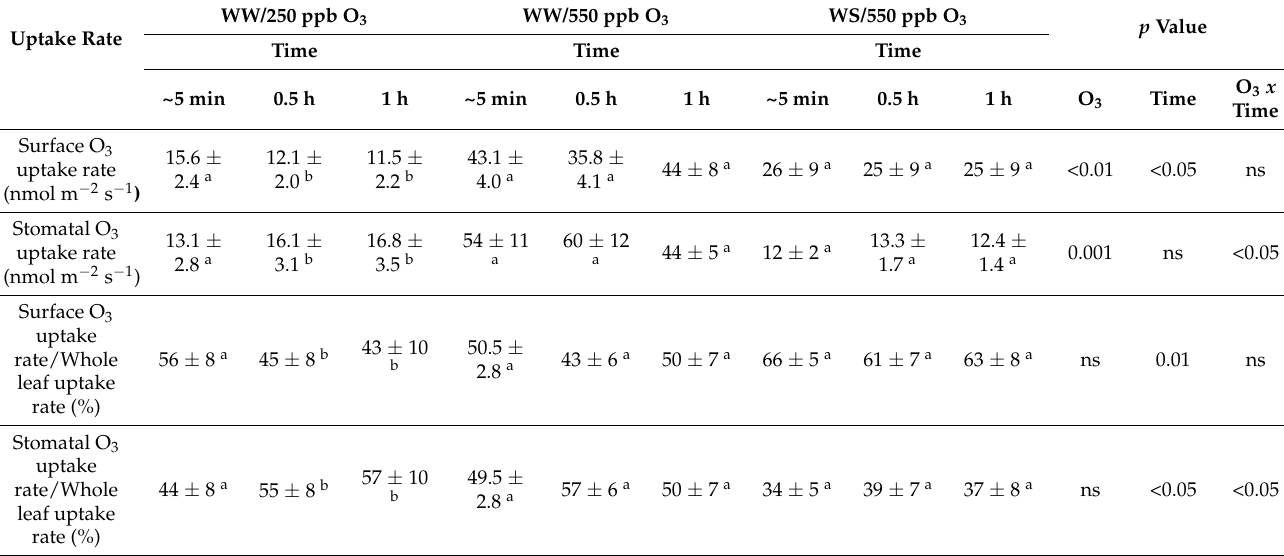
Table 1. Average surface and stomatal O 3 uptake rates and relative uptake rates at the beginning (~5 min), in the middle (0.5 h) and at the end (1 h) of fumigation with 250 ppb or 550 ppb O 3 for well-watered (WW) and water-stressed (WS) Brassica nigra